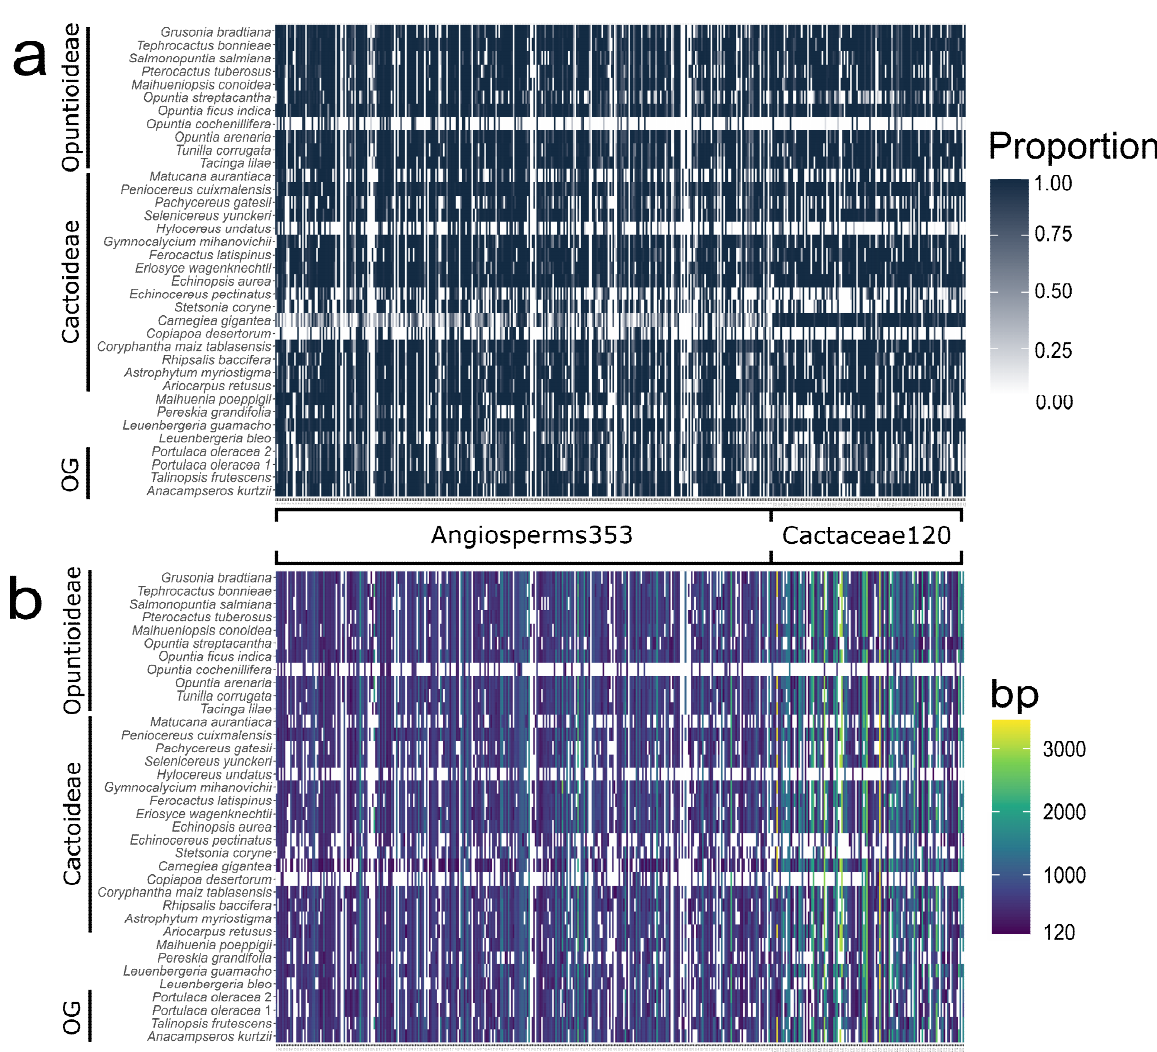
Figure 2. Heatmap plot showing recovery efficiency. Columns represent the targeted loci grouped based on probe sets and rows represent the 36 transcriptomes grouped based on the main groups in Cactaceae (OG: outgroup). ( a ) Length proportion of the target sequences recovered. ( b ) Size of the target gene sequences recovered.